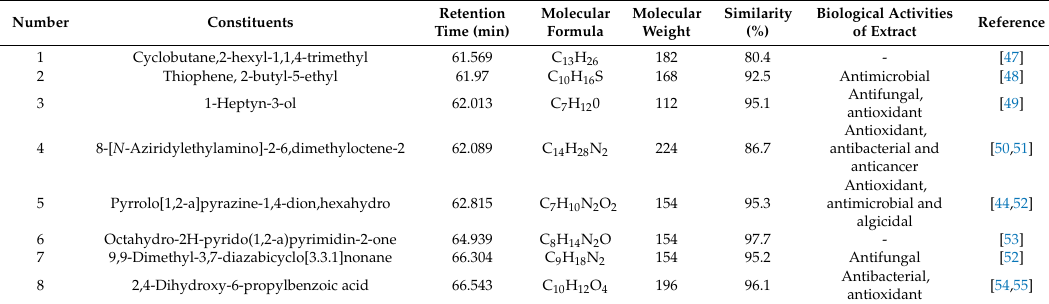
Table 2. GC-MS analysis of the chemical constituents present in the methanolic extract of strain MUSC 125.